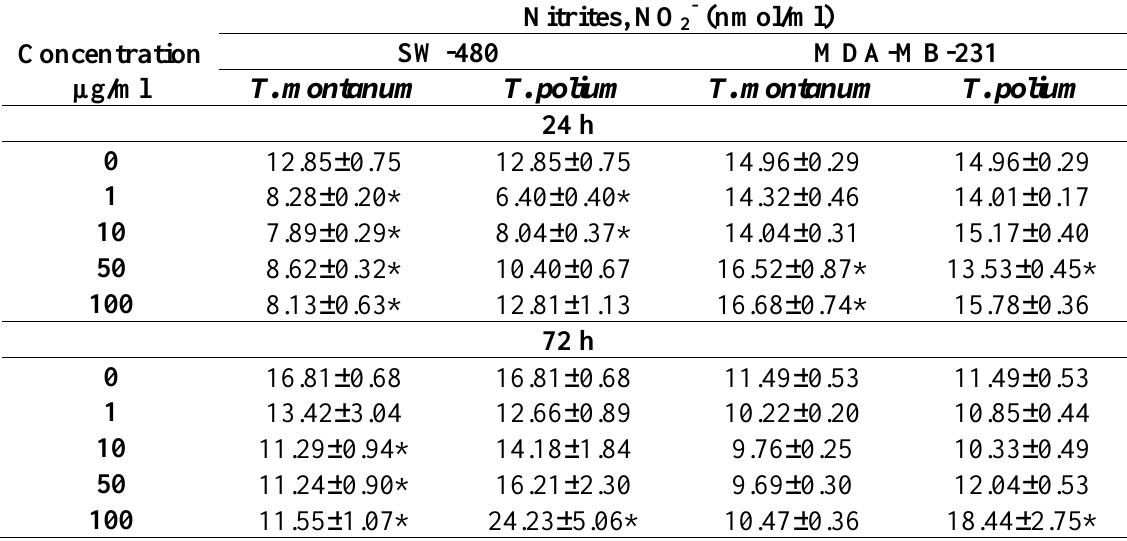
Table 2. Effects of methanolic extracts of Teucrium montanum and T. polium on SW-480 and MDA-MB-231 cell lines, expressed as the NO 2– concentration after 24 h and 72 h of exposure. *p < 0.05 as compared to the control cells.